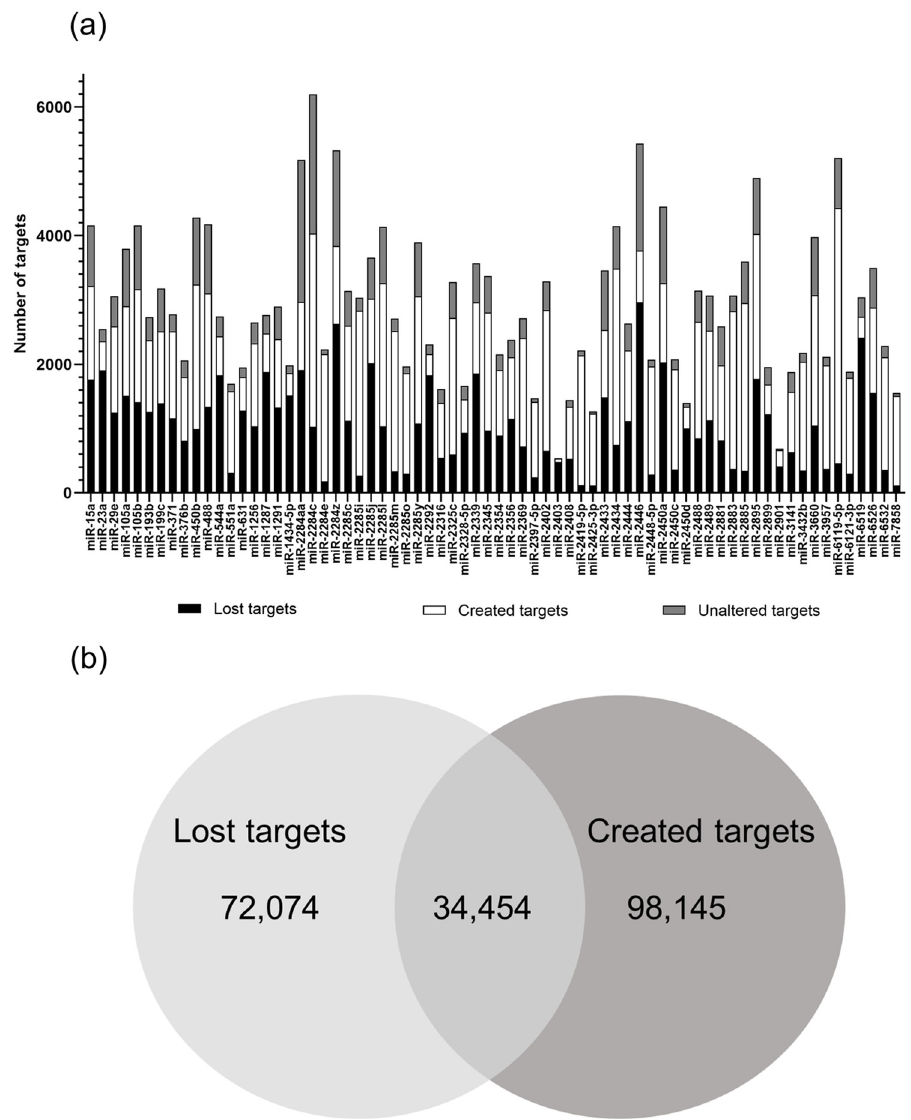
Fig 2. Changes in target prediction. Prediction of gained, lost and unaltered targets of mature miRNAs containing SNP (a). Venn diagram depicting all created, lost and maintained targets (b).